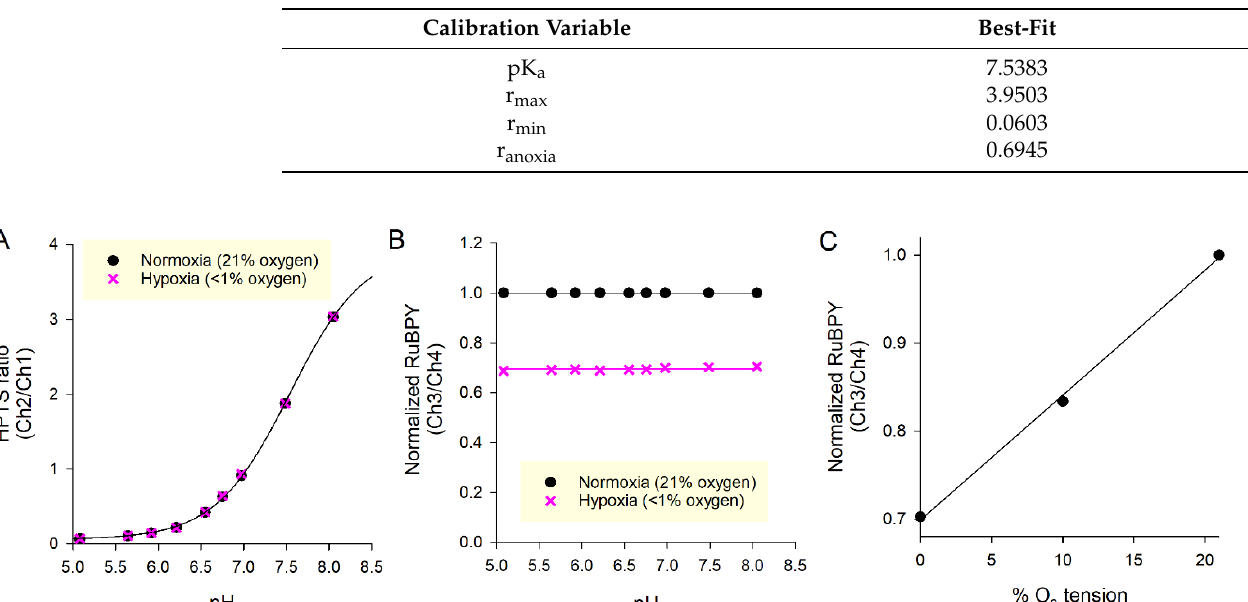
Table 1. Best fit to calibration curves in Equations (1) and (2).